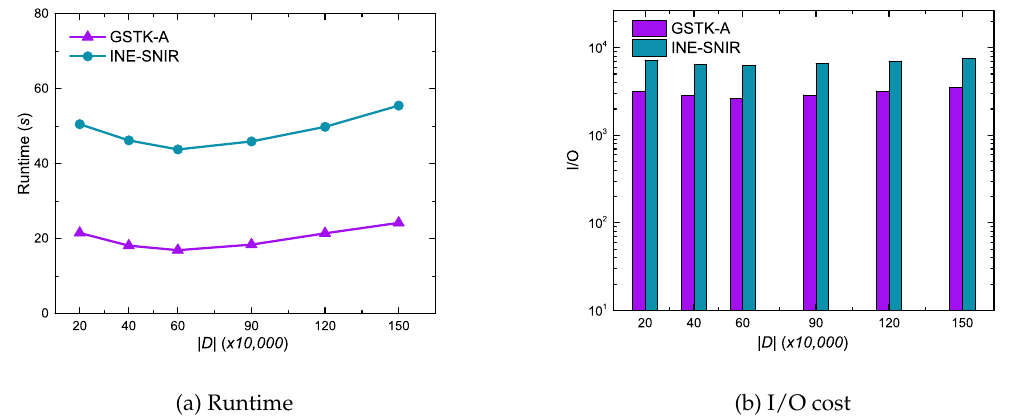
Figure 9. Effect of the number of data objects on runtime and I/O cost.